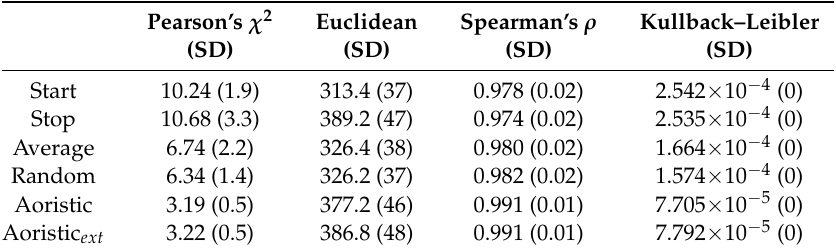
Table 8. Mean and standard deviation for the four evaluation measures and the six temporal analysis methods that were evaluated with the month data over each of the five